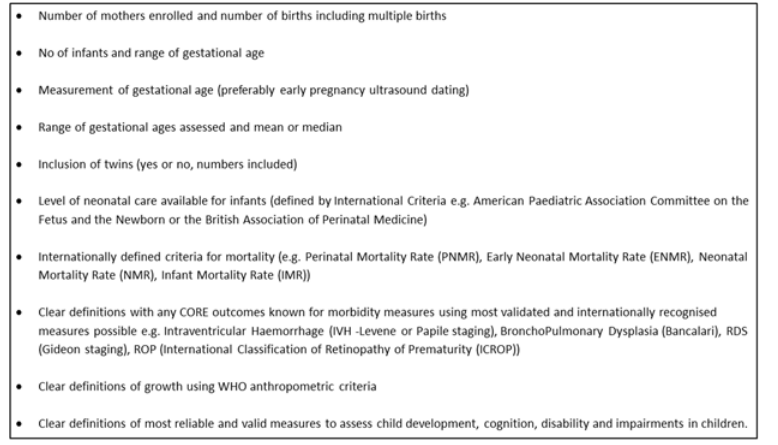
Fig 4. Recommended reported measures for studies on neonatal